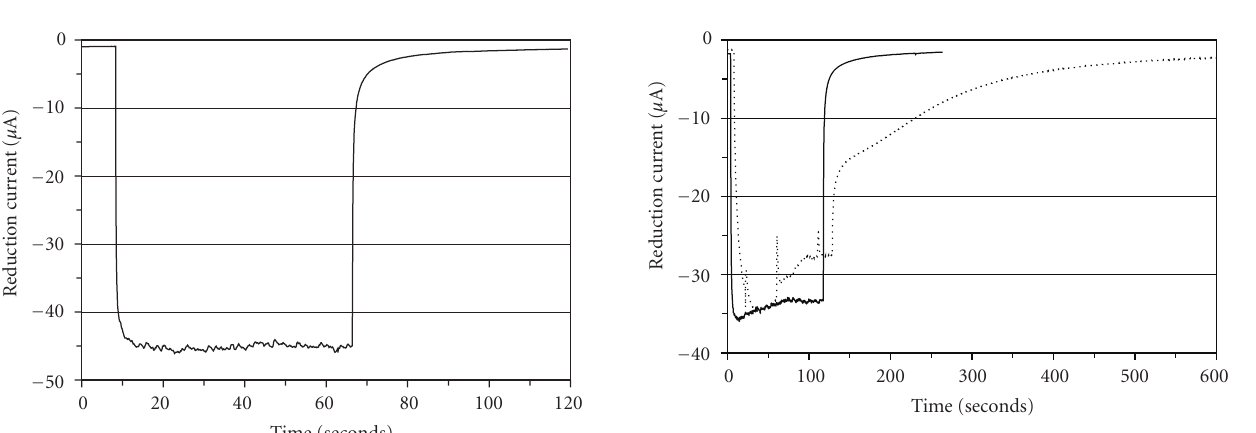
Figure 9: Comparison of di ff usion tails for 3.0MeV protons (dotted) and 1.2MeV protons